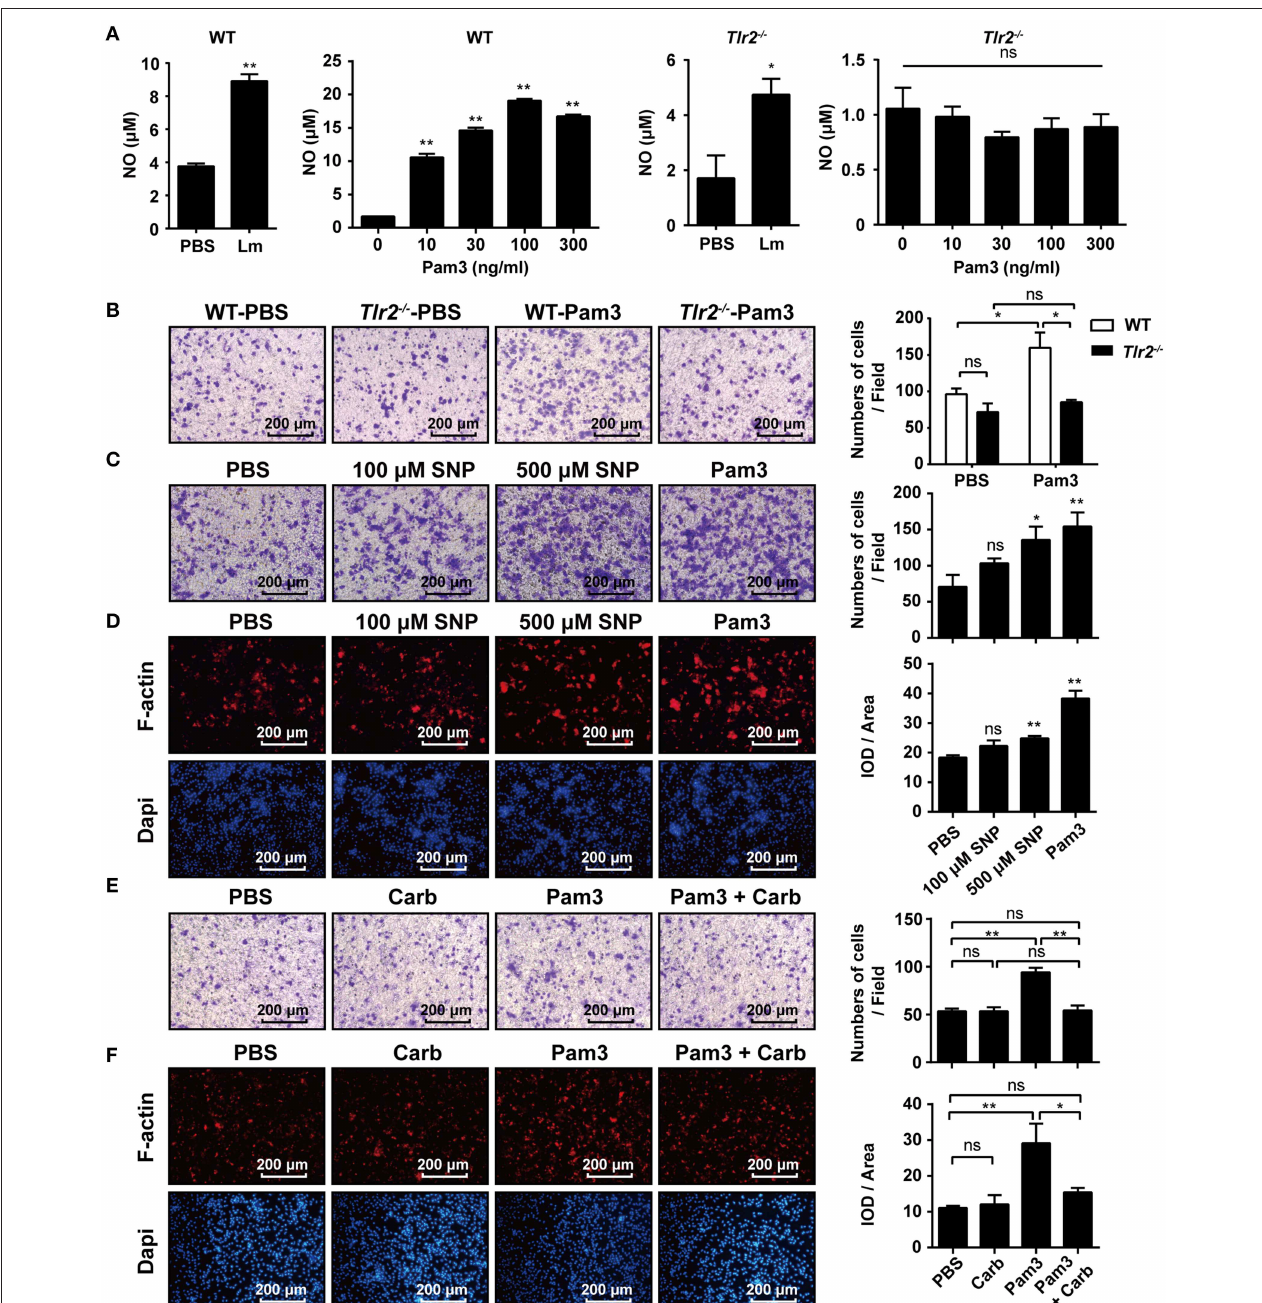
FIGURE 4 | TLR2-NO pathway regulates F-actin polymerization. (A) Macrophages derived from WT and Tlr2 − / − mice were infected with Lm (MOI = 10:1) for 1h in vitro , then treated with gentamicin and cultured for 12h, or stimulated with different doses of Pam3CSK4 for 12h. The level of NO in the supernatant was detected. (B) Macrophages from WT and Tlr2 − / − mice were stimulated with 100ng/mL Pam3CSK4. The mobility of peritoneal macrophages was measured using a transwell chamber migration assay. (C) WT macrophages were added to the inserts and stimulated with SNP (NO donor), Pam3CSK4, or PBS as a control. Photographs were taken after 4h of migration. (D) WT macrophages were stimulated with SNP, Pam3CSK4, or PBS as a control for 1h. F-actin was detected by rhodamine-phalloidin staining. Red, F-actin; blue, Dapi. (E,F) WT macrophages were pre-treated with the NO scavenger, Carboxy-PTIO, or PBS as a control, then stimulated with Pam3CSK4. Cellular mobility was measured using a transwell chamber migration assay (E) , and F-actin was detected by rhodamine-phalloidin staining (F) . The ratio of integrated optical density (IOD) to area of interest was calculated to assess the level of F-actin (D,F) . Red, F-actin; blue, Dapi. B-F, one representative image of three independent experiments. Data are presented as the mean ± SEM of three independent experiments. * p < 0.05, ** p < 0.01.